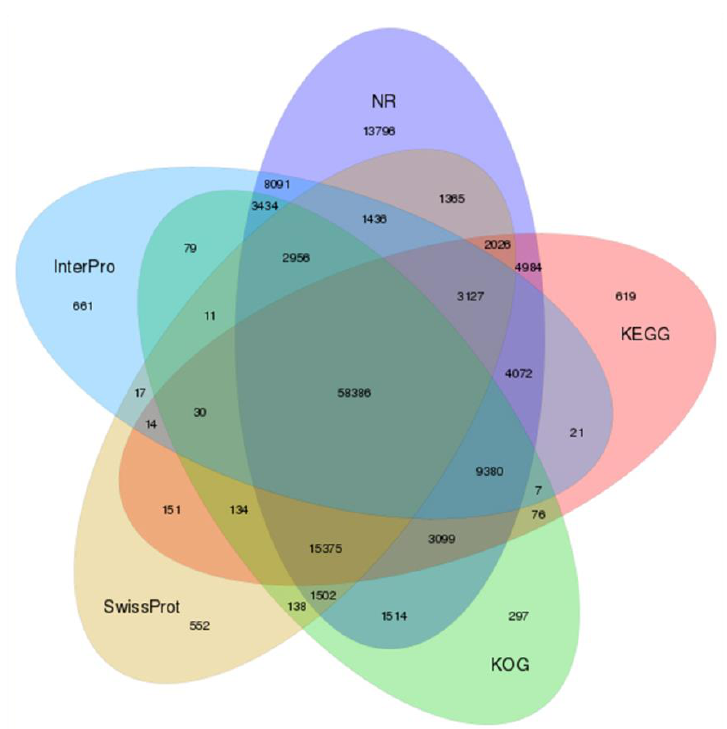
Figure 2. Venn diagram. A total of 32,574 annotated unigenes between the NR, COG, KEGG, SwissProt, and InterPro databases were identified by the Venn diagram.